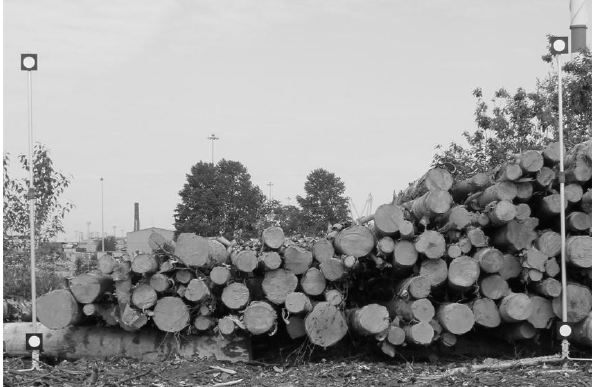
Figure 9. Log stack section with photogrammetric probes These spatial coordinates define a plane on which an orthophoto is generated and in which the frontal stack area is calculated (Figure 10). In this plane vertical lines with a period of approximately 1 meter are drawn for section height determination.